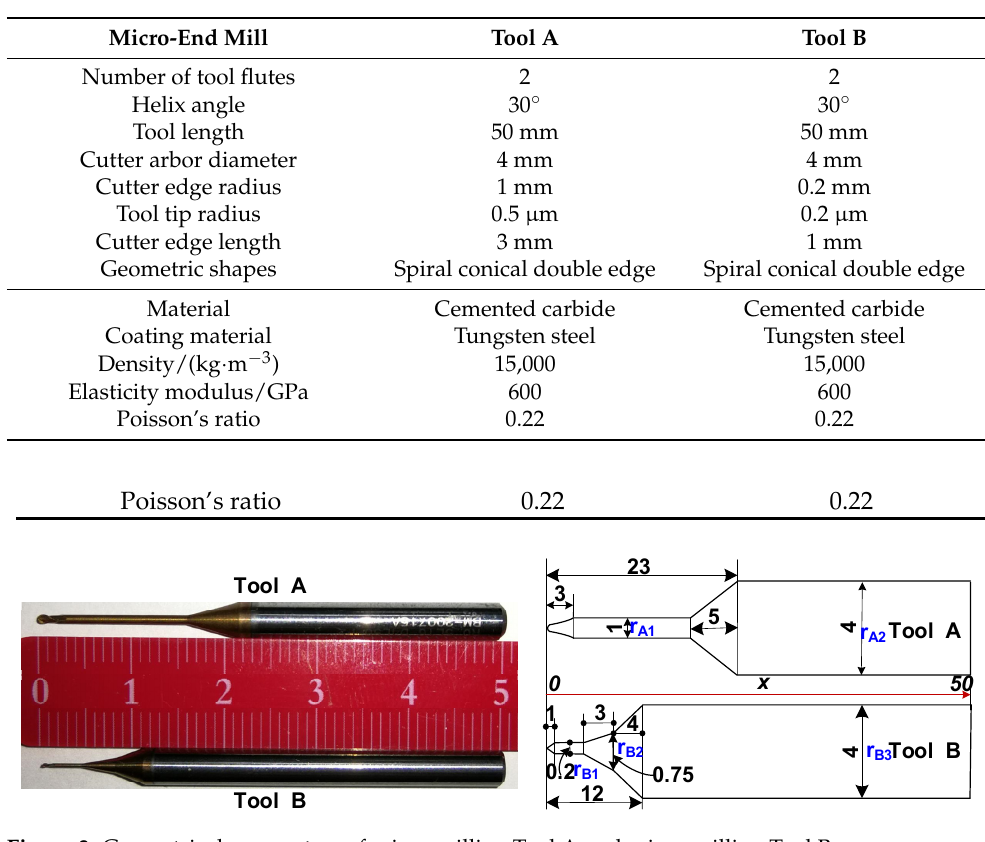
Figure 3. Geometrical parameters of micro-milling Tool A and micro-milling Tool B.